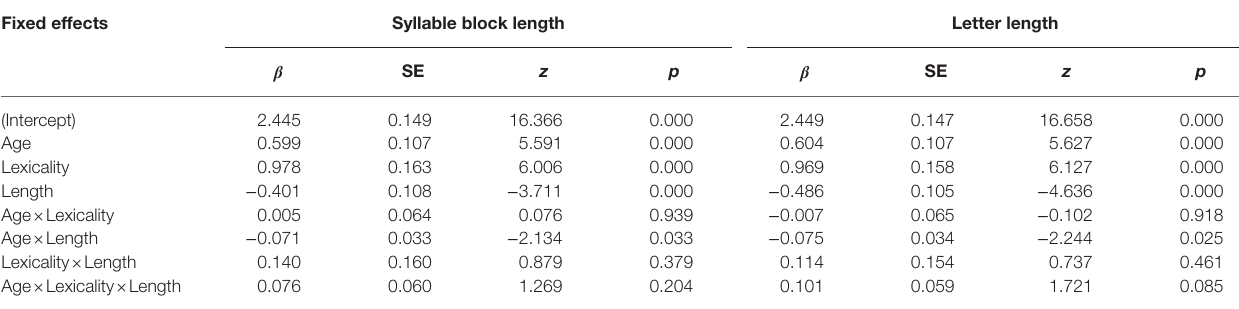
TABLE 3 | Estimates of fixed effects in reading accuracy: age × lexicality × length. Fixed